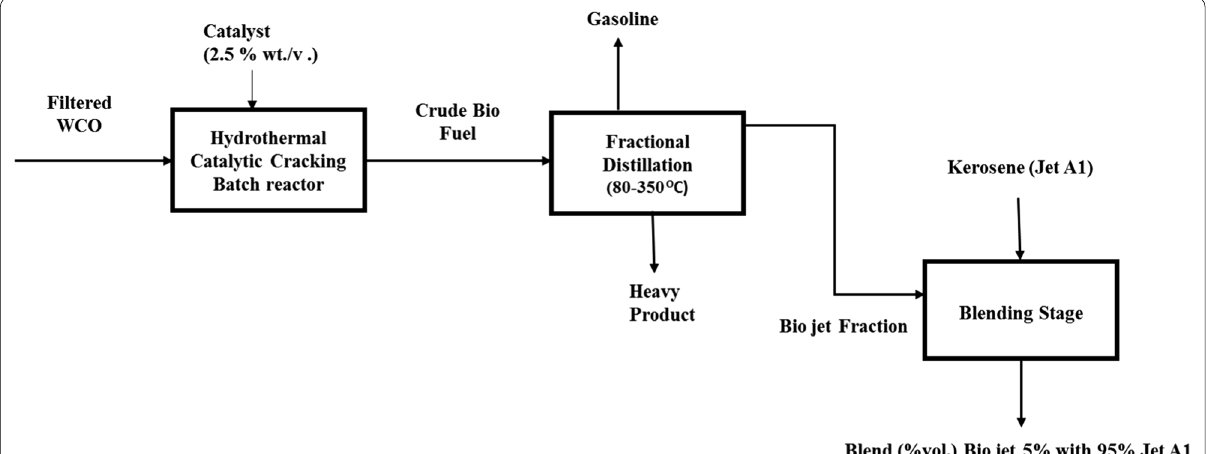
Fig. 1 Hydrocatalytic cracking process of WCO bio jet production